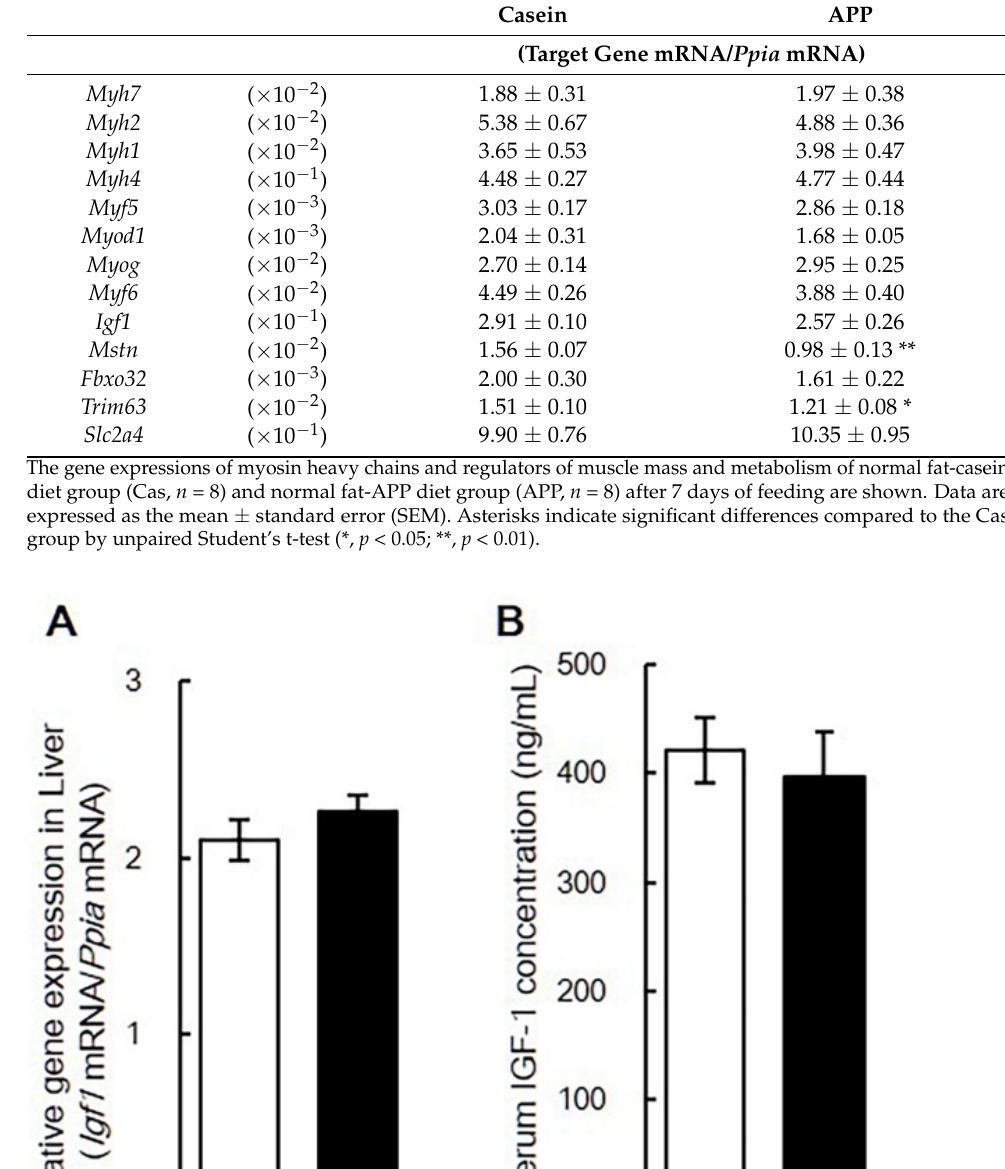
Table 5. Effect of APP for 7 days on gene expressions of myosin heavy chains and regulators of muscle mass and metabolism in the gastrocnemius muscles in rats fed a normal-fat diet.